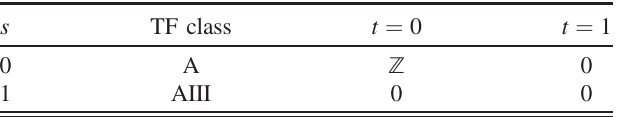
TABLE XXII. The subgroups ker ω k ⊆ K ð s; t j 0 ; 0 ; 0 ; 0 Þ for complex Shiozaki-Sato classes with a unitary order-two